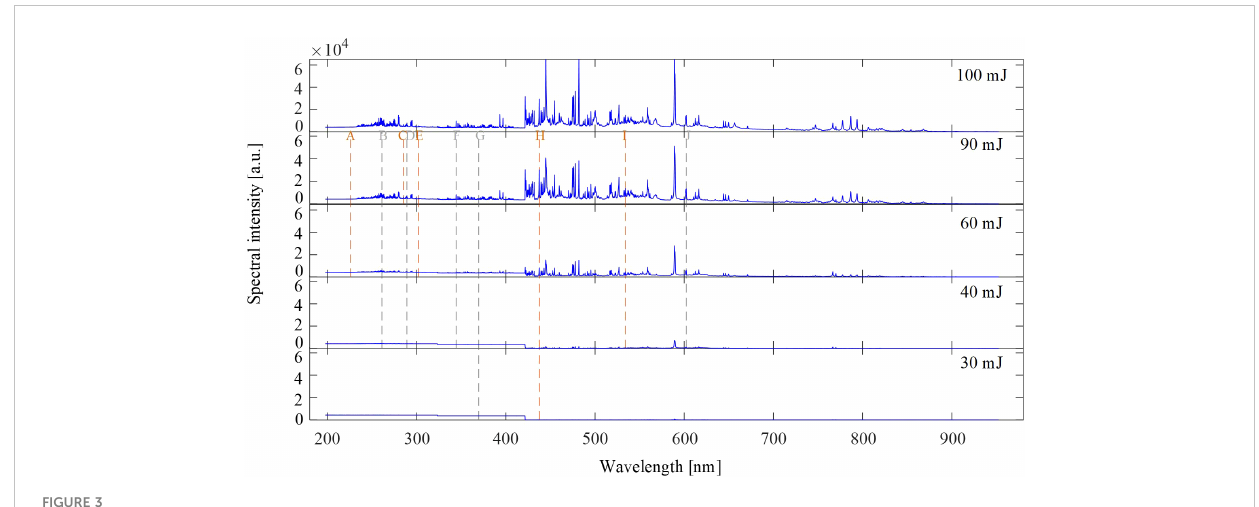
FIGURE 3 The spectra of the sample at a laser energy of 30 – 100 mJ.